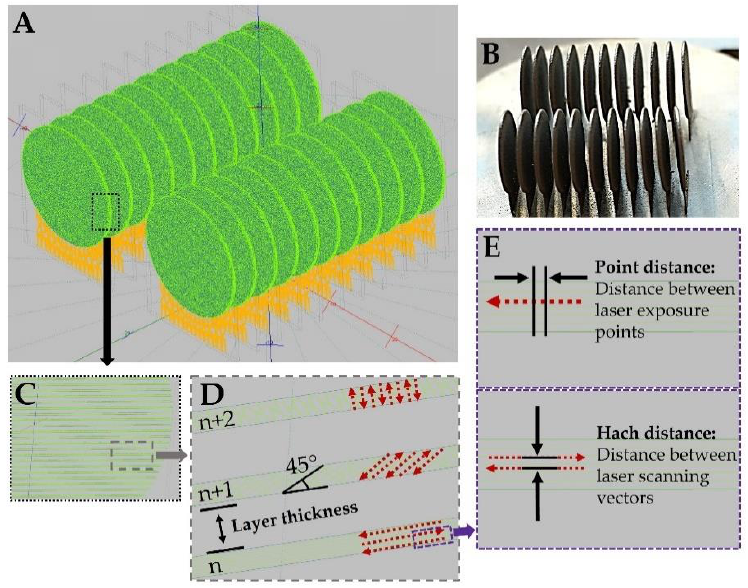
Figure 1. CAD models of sample discs (green) with support structures (yellow) after PBF-LB process parameters ( A ); fabricated 3D titanium samples ( B ); representative disc sample with visible layers in CAD model ( C ); alternating scanning strategy with visible distance between layers ( D ); laser exposure points (point distance) and distance between laser scanning vectors (hatch distance) ( E ).